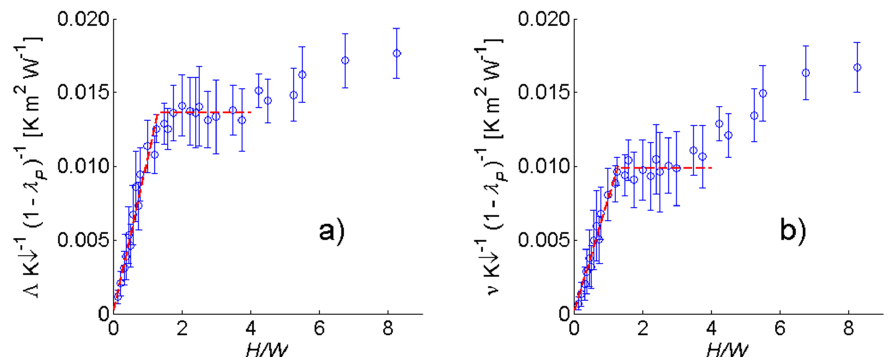
Figure 8. Maximum anisotropy ( a ) and maximum difference from nadir ( b ), both divided by forcing shortwave radiation ( K ↓ ) and canopy area (1 − λ P ), as a function of canyon height-to-width ratio. Median values with interquartile range (error bars) are plotted for each H/W . Slopes of best fit lines for H/W ≤ 1.25 (in red) are 0.011 and 0.008, respectively, with R 2 values of 0.93 and 0.94, respectively. Constant values (dashed horizontal red lines) for 1.25 < H/W < 4.0 are 0.014 and 0.010, respectively.